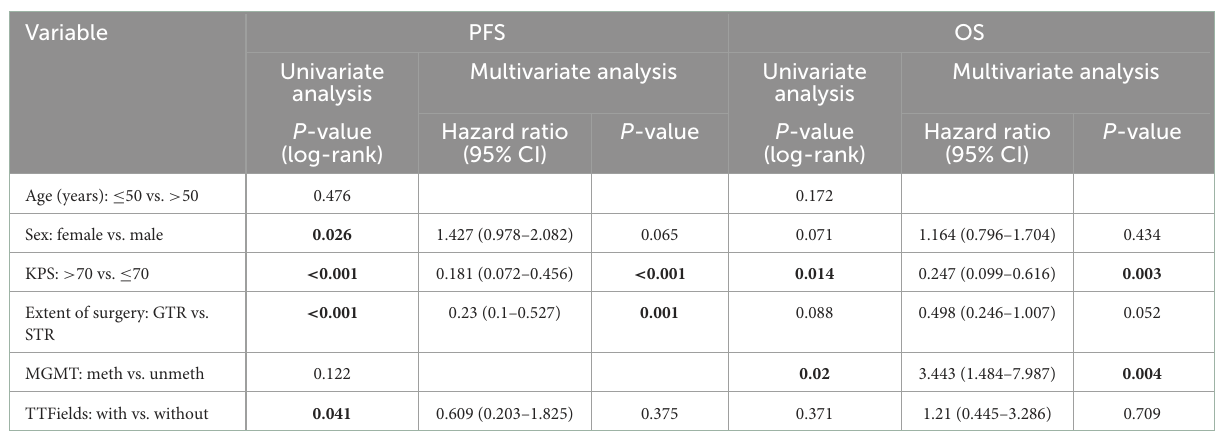
TABLE 2 Univariate and multivariate analysis for PFS and OS of